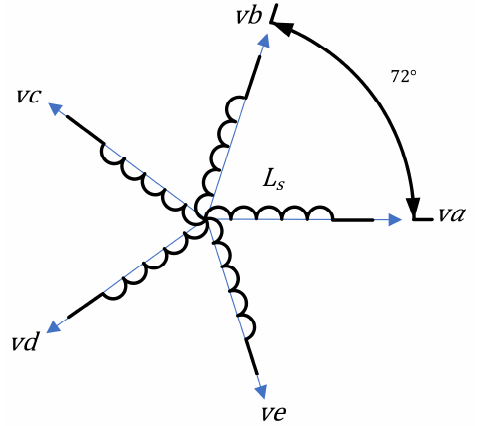
Figure 3. Five-phase stator winding for star connection.